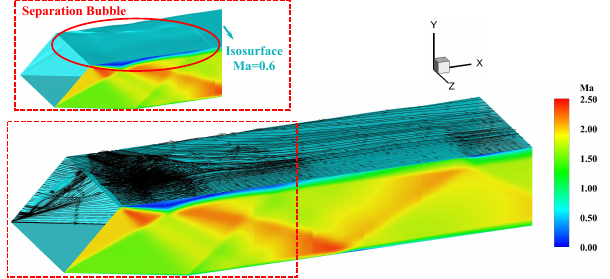
Figure 12. 3D effects of binary supersonic inlet/isolator’s side wall.